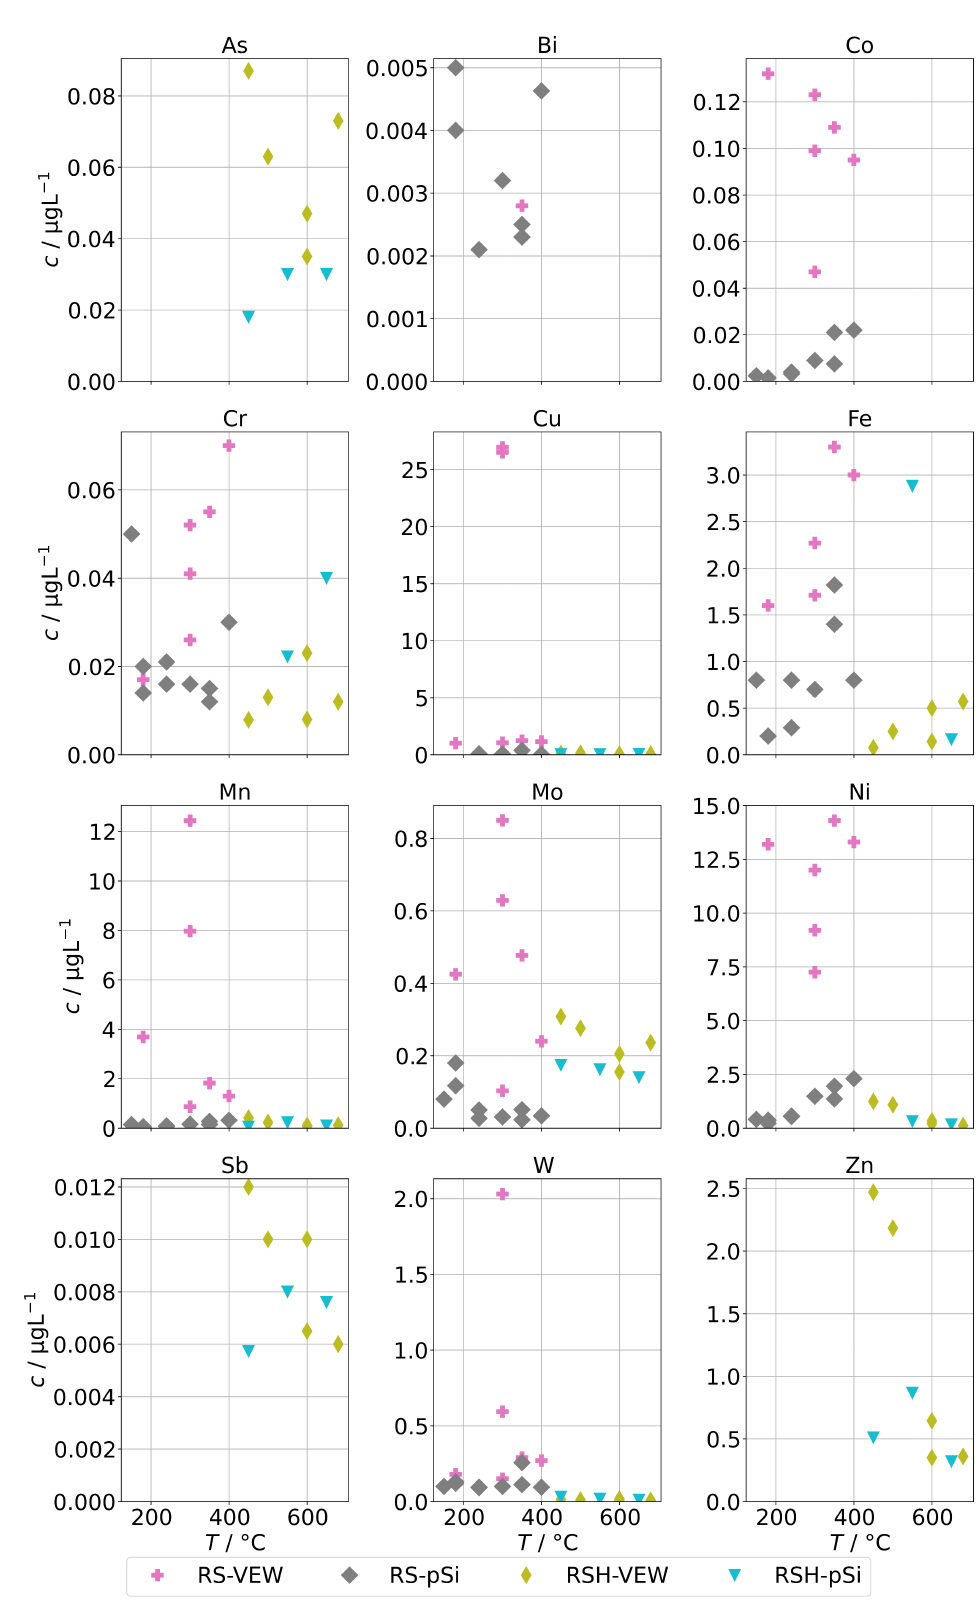
Figure 4. Background concentrations of quantifiable species in condensates of the AG-SG (group A) in dependence of operation